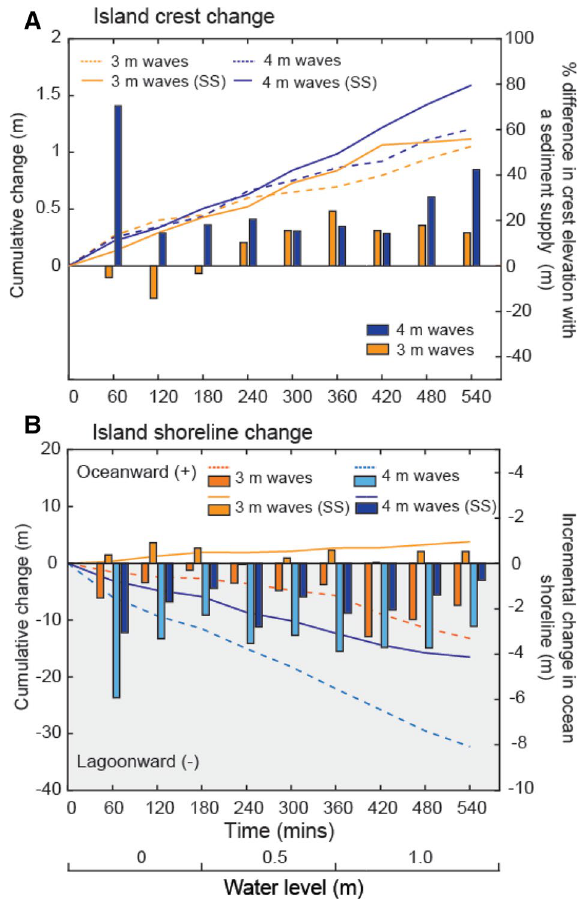
Figure 2. Comparison of changes in ( A ) ocean crest elevation, and ( B ) shoreline migration, under 3 m and 4 m waves with and without a sediment supply. ( A ) Cumulative change in crest elevation across each simulation (left axis) and the relative effect of sediment supply on crest growth at each time-step (right axis) under 3 m and 4 m waves. ( B ) Cumulative shoreline movement across each simulation (left axis) and incremental shoreline change at each time-step (right axis) with and without a sediment supply under 3 m and 4 m waves. There is no change in crest accretion and shoreline erosion at T 0